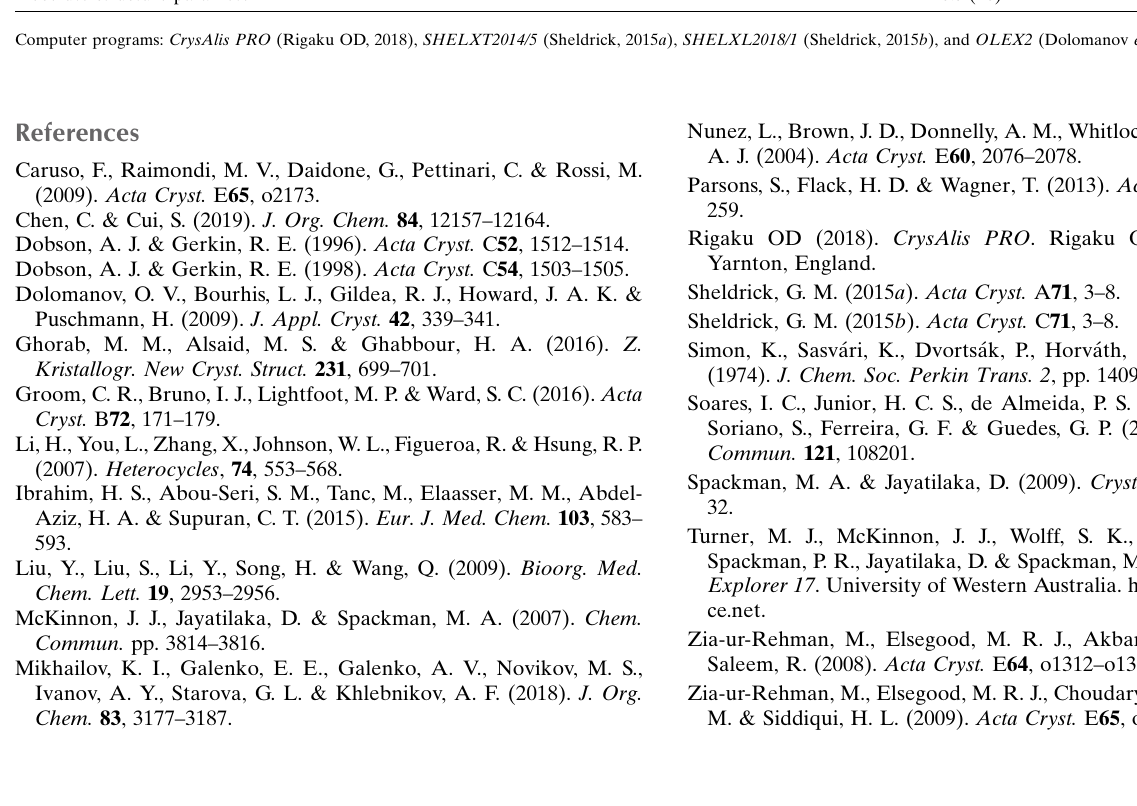
Crystal data Chemical